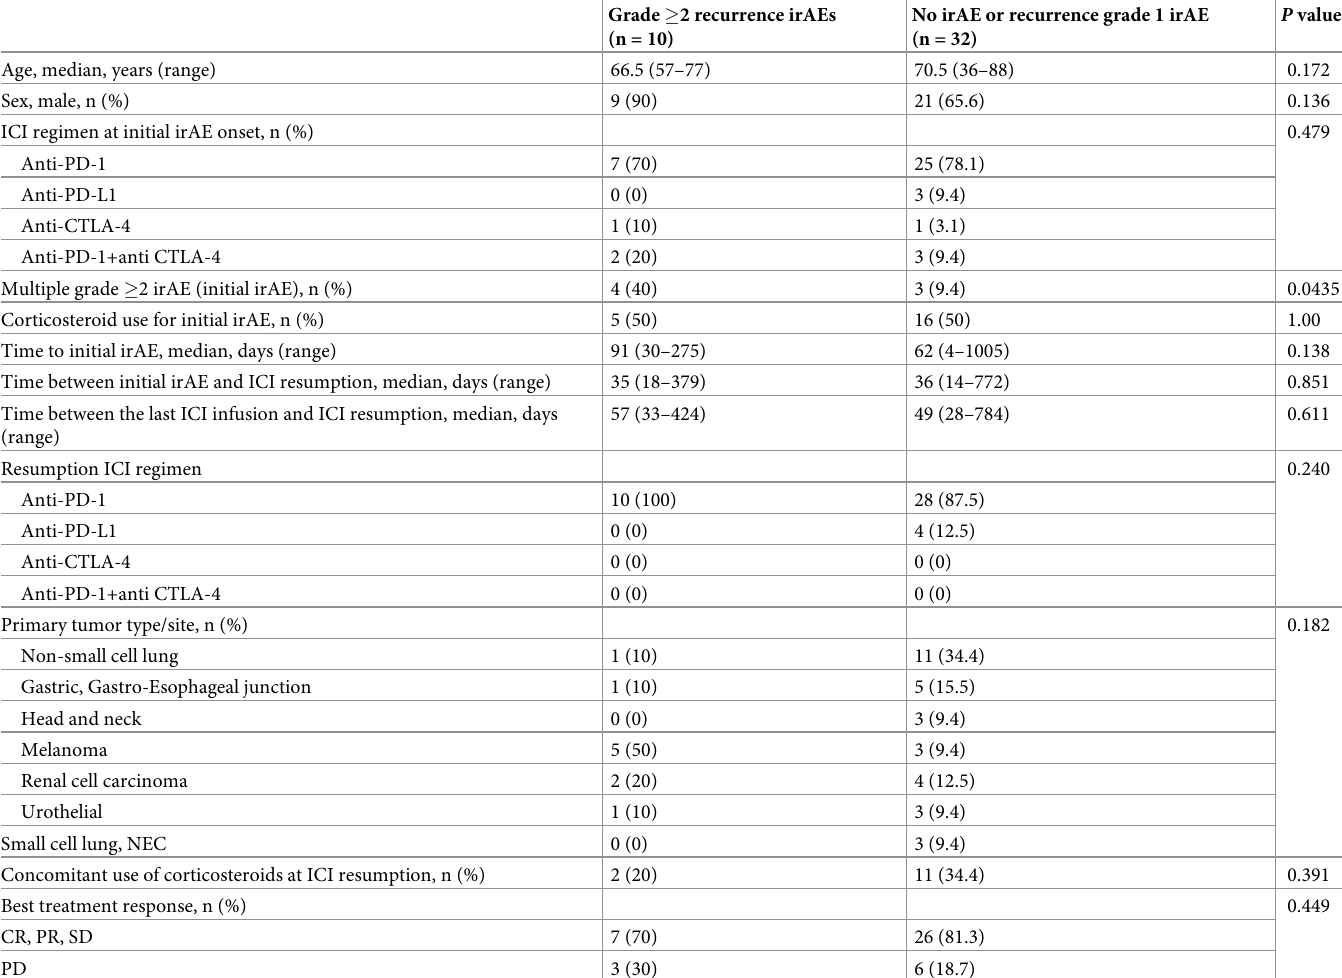
Table 3. Factors associated with the recurrence of grade � 2 irAEs after ICI